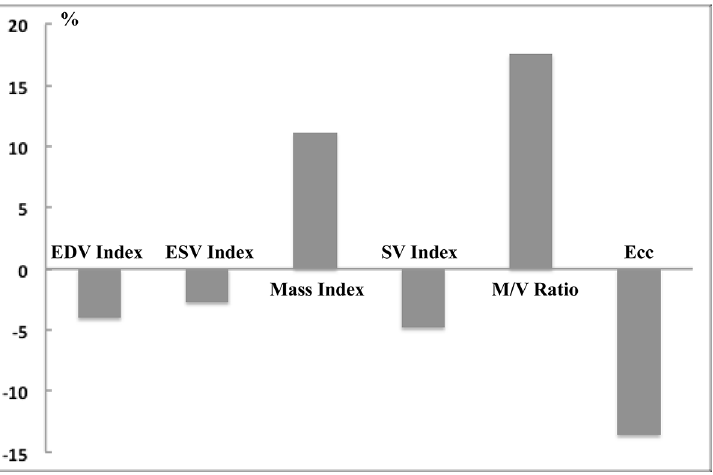
Fig 1. Comparison of LV indices between study subjects with versus without cardiovascular risk factors. Percent difference [100 × (with-risk − risk-free) ⁄ risk-free] are shown. All displayedindices are significantly different betweenwith-risk and risk-free groups.